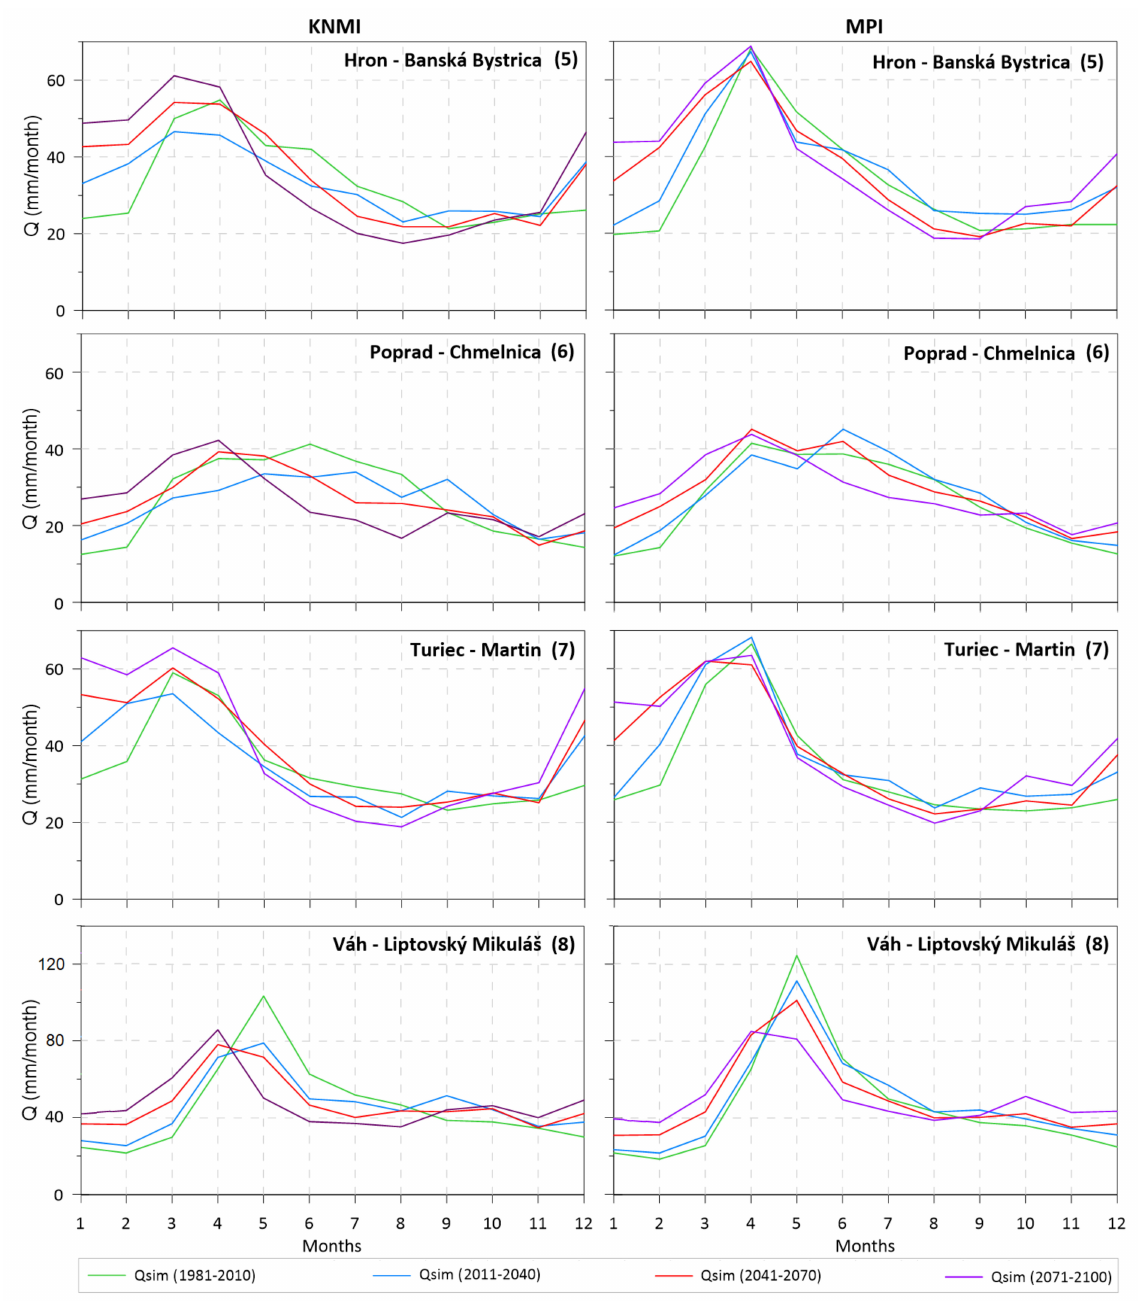
Figure 7. Long-term mean monthly runoff projected for the reference period (1981–2010) and three future time hori- zons (2011–2040, 2041–2070, 2071–2100) according to the KNMI and MPI scenarios for the river basins with a mean elevation > 435 m